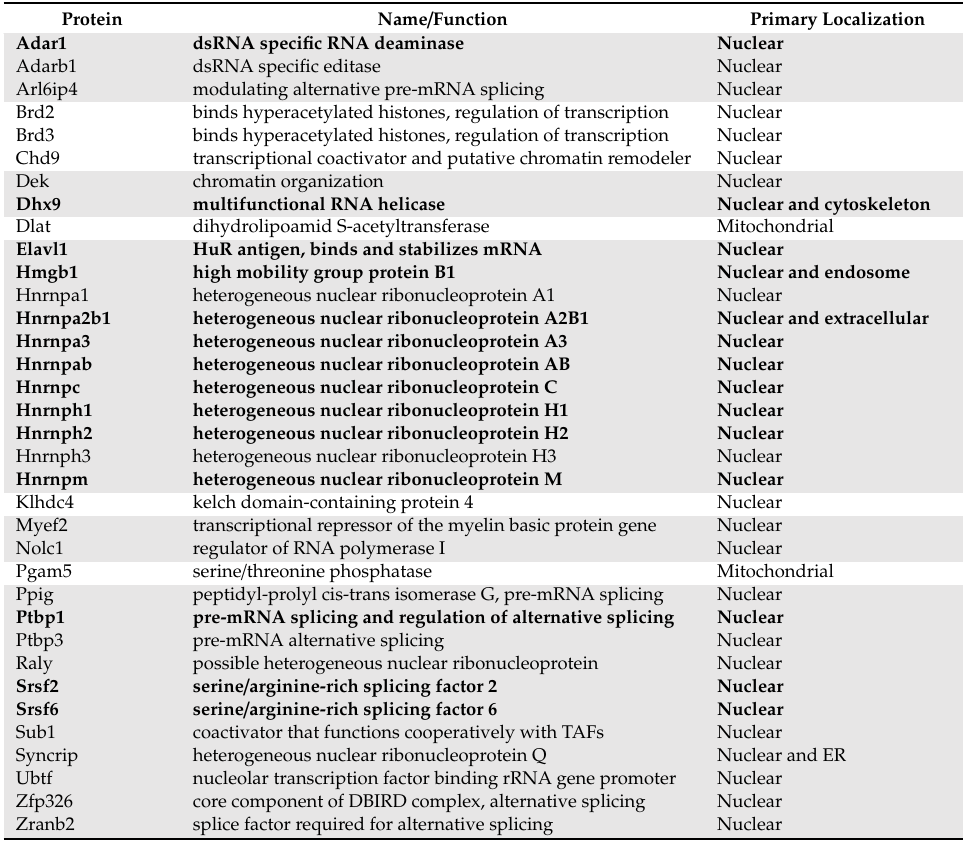
Table 1. List of the proteins found to be enriched at murine Malat1. Proteins marked in bold were already known to interact with human or mouse MALAT1 from previous studies. Proteins with a gene ontology annotation for RNA-binding are shaded in